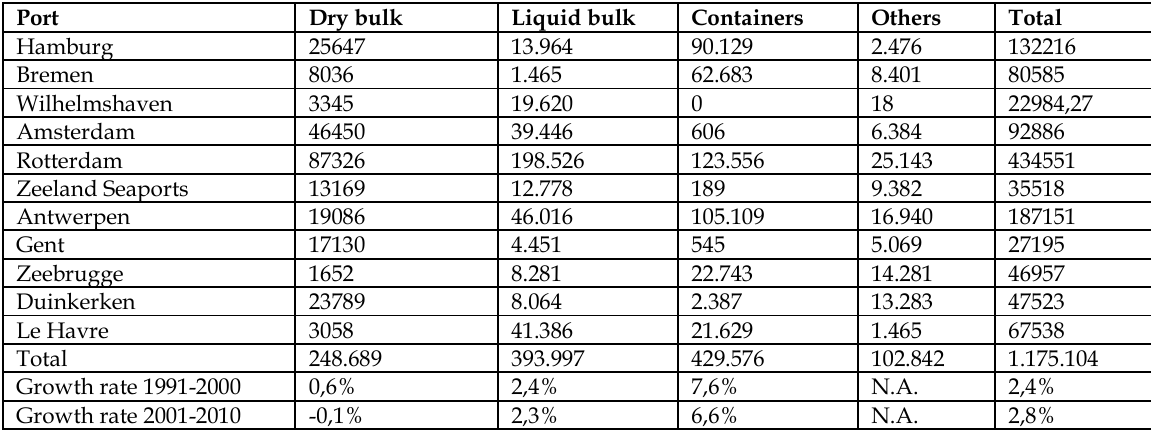
Table 1. Throughput volumes 2011 Hamburg – Le Havre